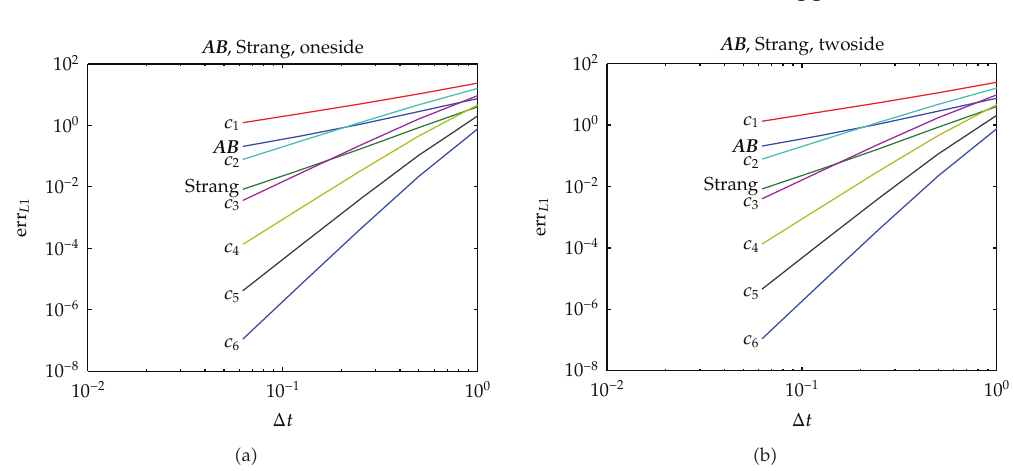
Figure 1: Numerical errors of the standard splitting scheme (cid:5) a (cid:6) and the iterative schemes (cid:5) b (cid:6) with 1 ,... , 6 iterative